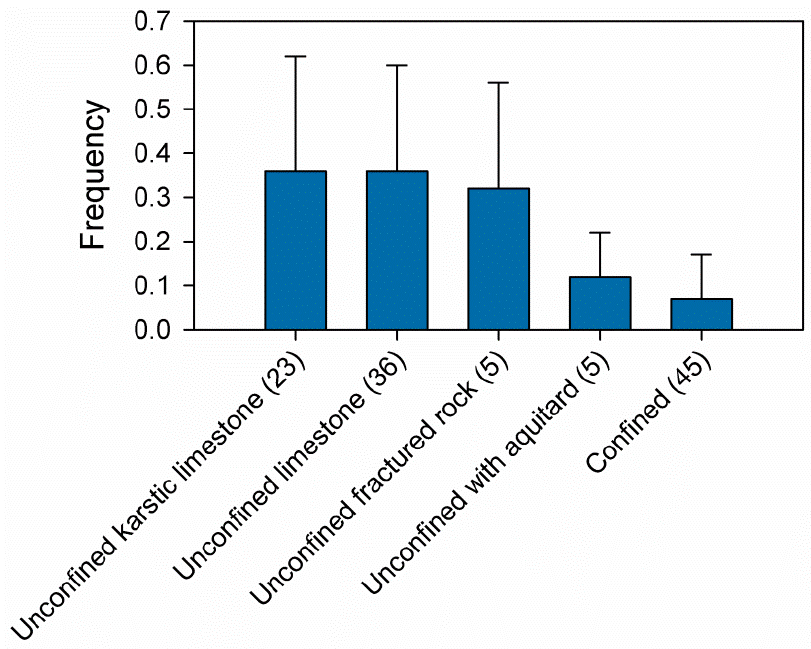
Figure 4. Frequency of coliform detection in relation to aquifer type and geological strata. Sample size is given in brackets.